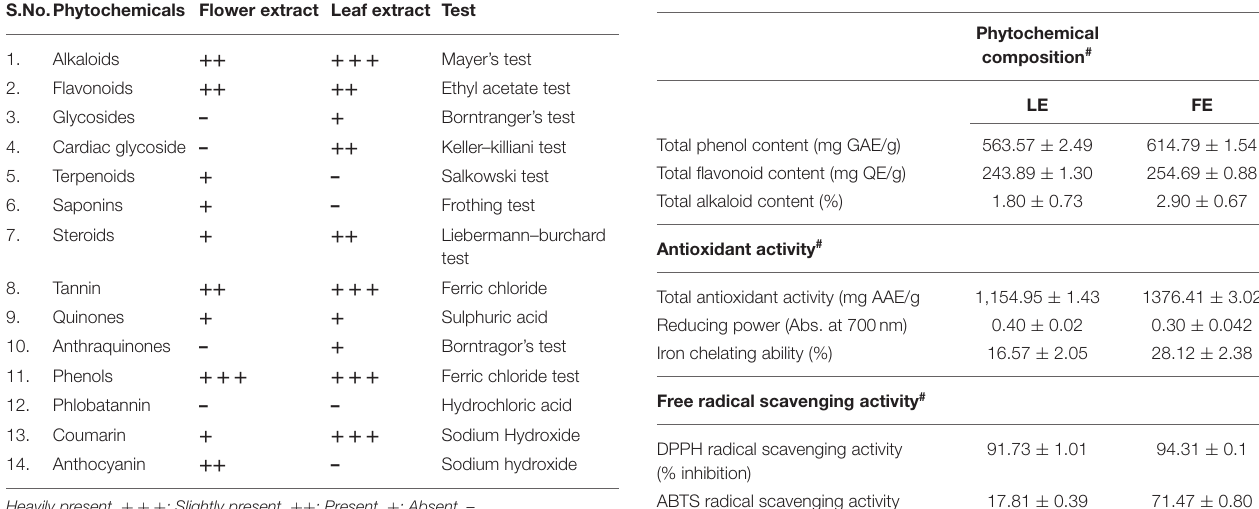
TABLE 1 | Phytochemical constituents of FE and LE of L. camara . TABLE 2 | Phytochemical composition, antioxidant activity, free radical scavenging capacity, and enzymatic activity of L. camara LE and FE.